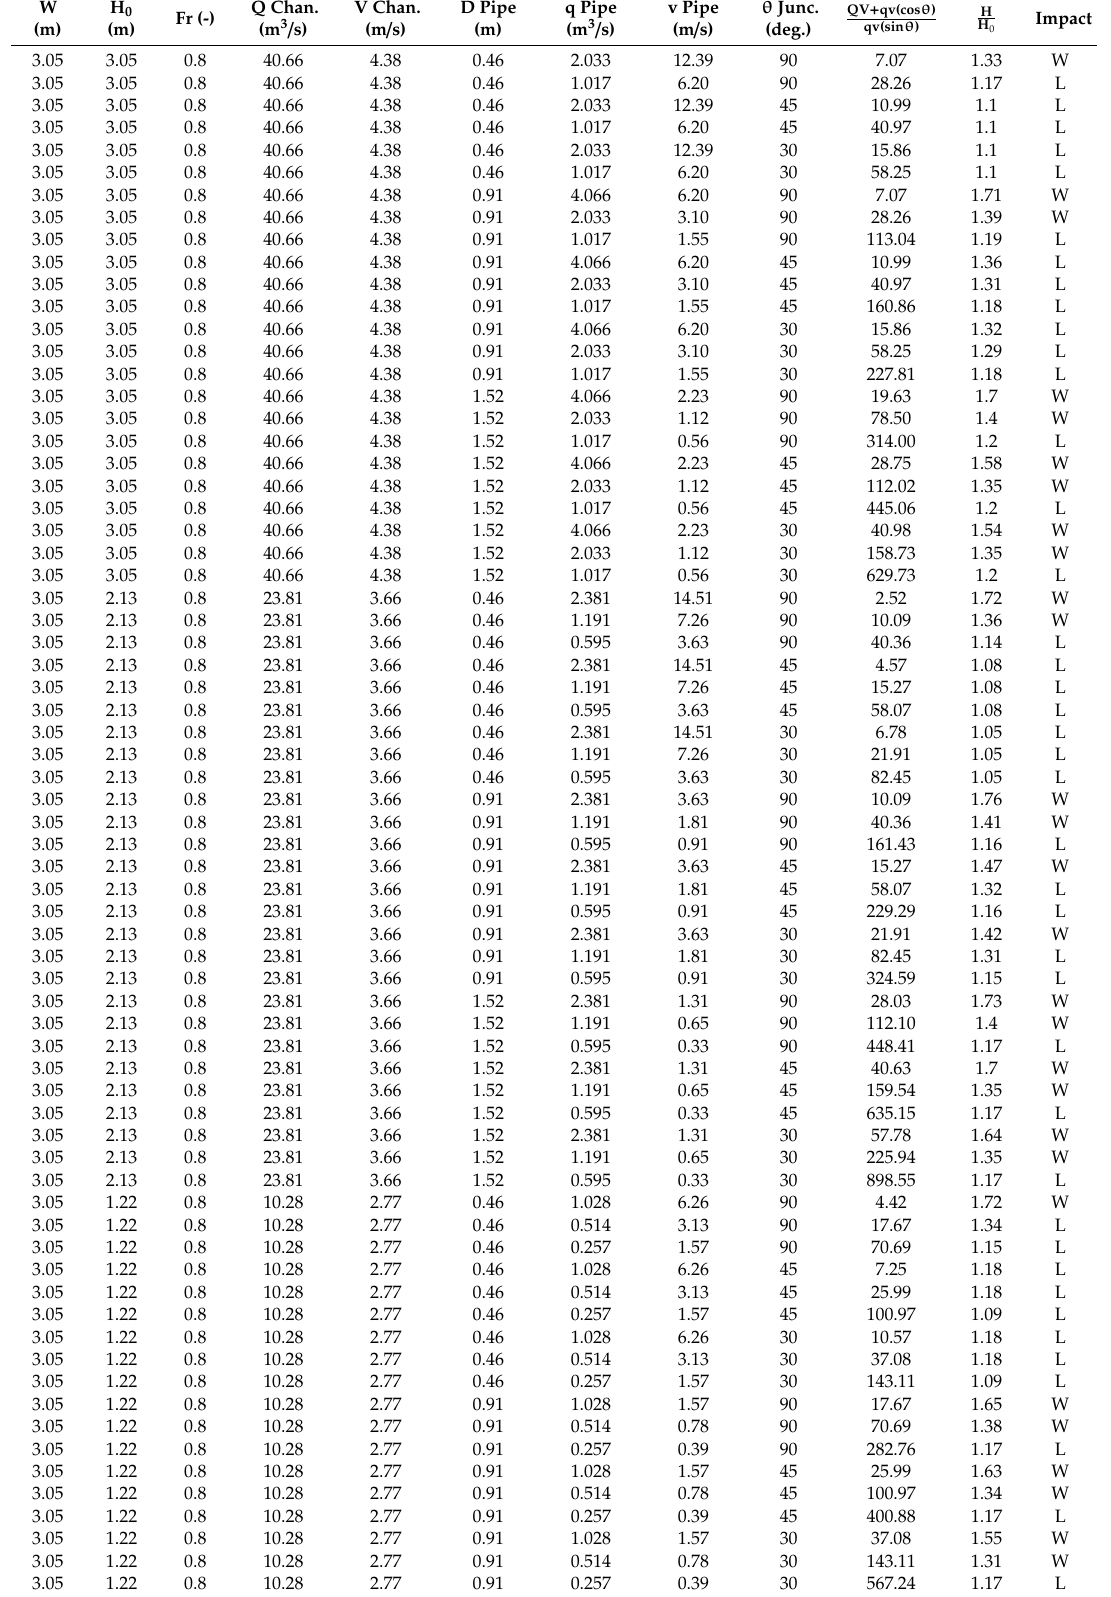
Table A7. FLOW-3D simulation results for W = 3.05 m (10 (cid:48) ) and Fr =